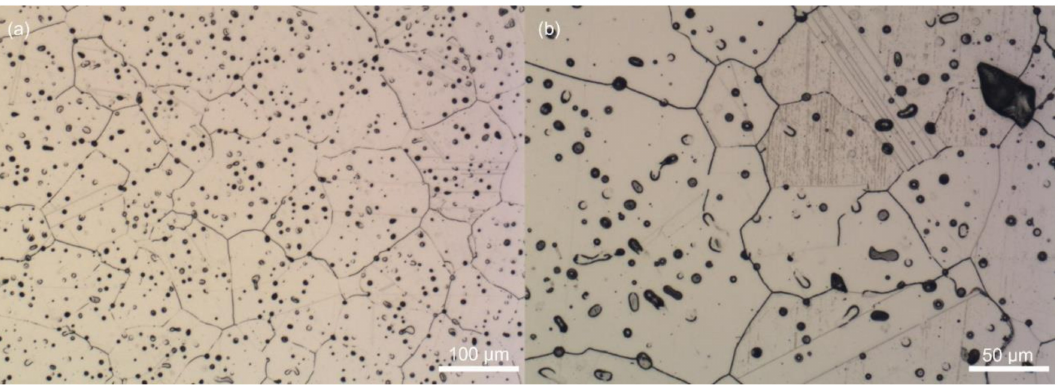
Figure8. Microstructureof316Lstainlesssteelsinteredat5 ◦ C / min( a )withthedetailofdeformation-induced martensite ( b